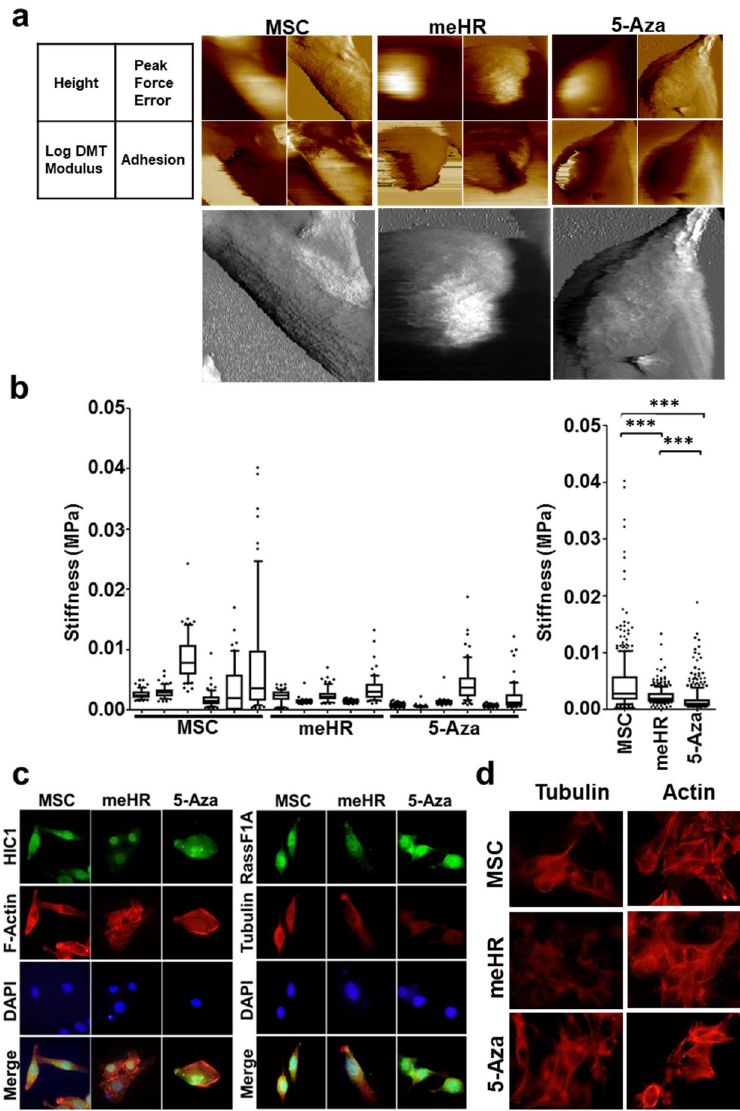
Figure 2. Loss of cell stiffness in me_HR-transformed mesenchymal stem cells (MSCs) is correlated with loss of tubulin expression, and it can be reversed by 5-aza-2′-deoxycytidine (5-Aza) treatment. ( a ) Cell surface morphology and cell stiffness of MSCs, me_HR-transformed MSCs, and 5-Aza-treated me_HR-transformed MSCs were measured using atomic force microscopy (AFM) as described. Four representative derived moduli of the AFM measurements are illustrated. The peak force error modulus is shown in black and white and is enlarged in the lower panels to highlight the surface spines (with 400 times magnification). ( b ) Loss of cell stiffness in me_HR-transformed MSCs. Representative cell stiffness measurements of at least five individual, me_HR-transformed, and 5-Aza-treated me_HR-transformed MSCs are box-plotted on the left (measurement was repeated twice, n = 3, *** p < 0.001). Overall stiffness distribution is plotted on the right. ( c ) Immunostaining of MSCs, me_HR-transformed MSCs, and 5-Aza-treated me_HR-transformed MSCs. MSCs, me_HR-transformed MSCs, and 5-Aza-treated me_HR-transformed MSCs were seeded in four-well chamber slides, and indicated antibodies were used to detect expression (with 400 times magnification). ( d ) Detection of tubulin and β-actin expression in MSCs, me_HR-transformed MSCs, and 5-Aza-treated me_HR-transformed MSCs (with 400 times magnification). Enlarged immunostaining data are illustrated in Figure S3. DMT: Derjaguin–Muller–Toporov.